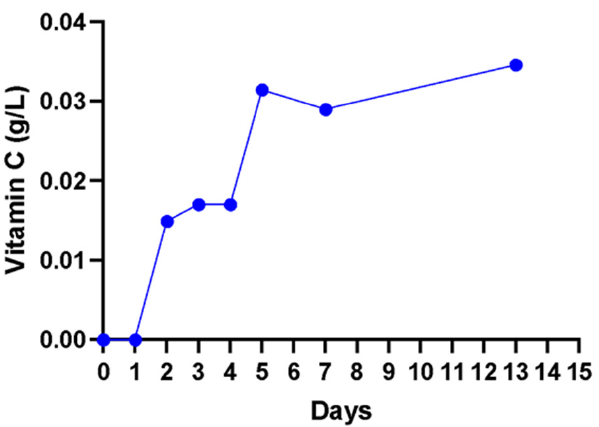
Figure 7. The change in vitamin C during the wine fermentation process.